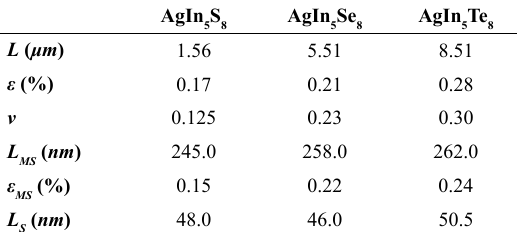
Table 1. Microstructural parameters ( L , ε , ν ) of the system AgIn determined from numerical fits with Equation (13), as discussed in Section 4. For comparison, the parameters obtained from the modified Scherrer (MS) and conventional Scherrer (S) formulae are also